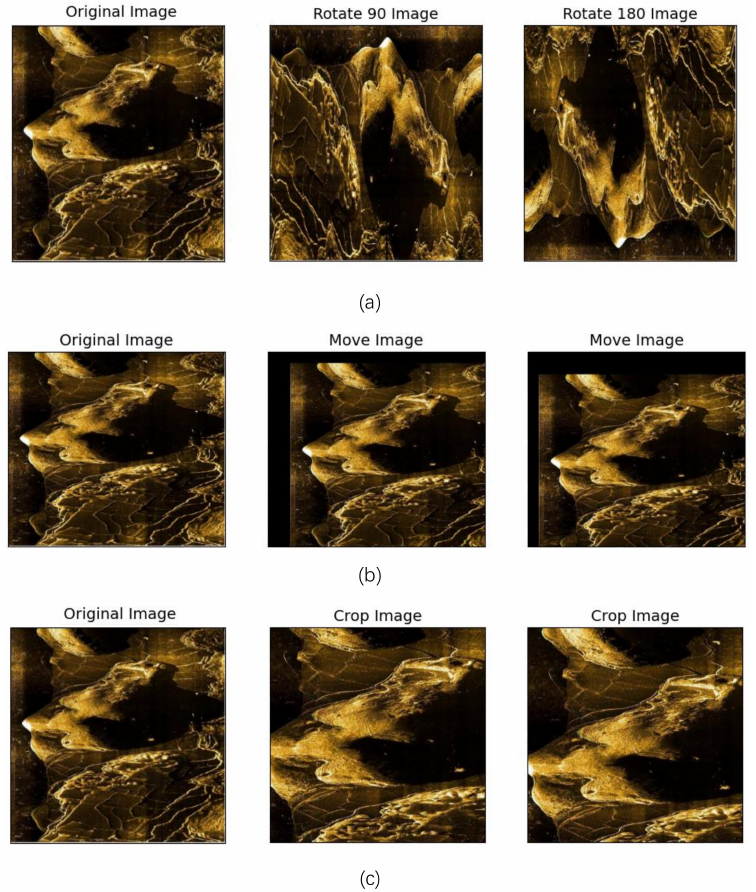
Figure 7. Data augmentation ( a ) image inversion, ( b ) image panning, ( c ) random